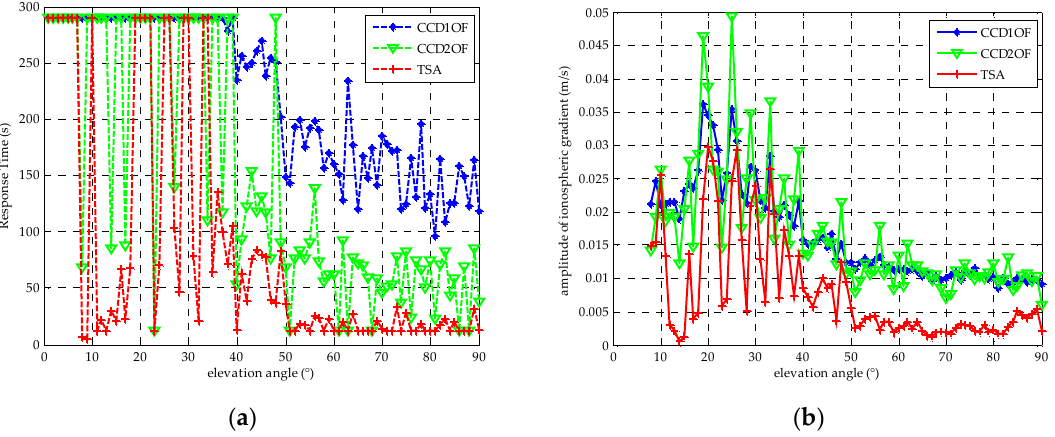
Figure 9. ( a ) The comparison of the response time to anomaly between TSA and the traditional CCD methods with the change of ionospheric gradient rate being 0.018 m/s for PRN 19; ( b ) the comparison of the detection sensitivity between TSA and the traditional CCD for PRN 19. Table 4. Mean and standard deviation of the response time between TSA and the traditional CCD methods with the change of ionospheric gradient rate being 0.018 m/s for PRN19.